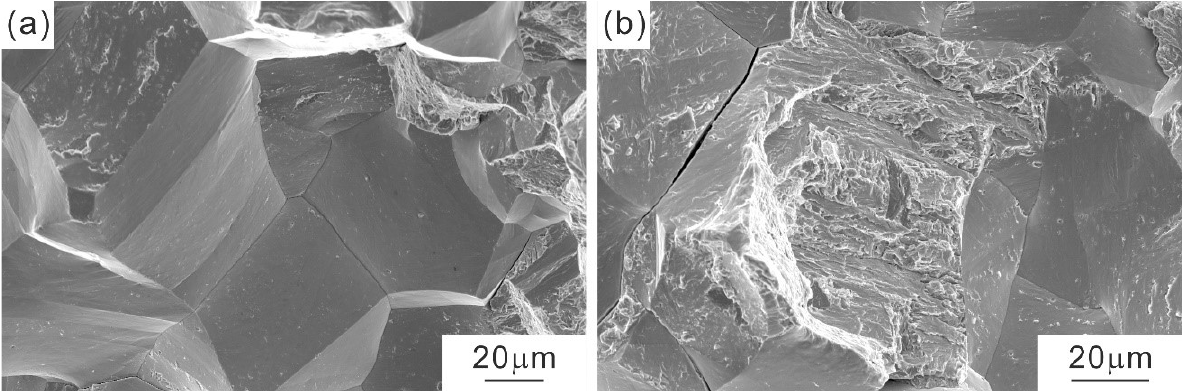
Figure 2. SEM images of the typical fracture surfaces; ( a ) intergranular surface and ( b ) quasi-cleavage surface (center area of the image) of the hydrogen-charged specimen with H D = 0.80 wt. ppm after the slow strain rate tensile